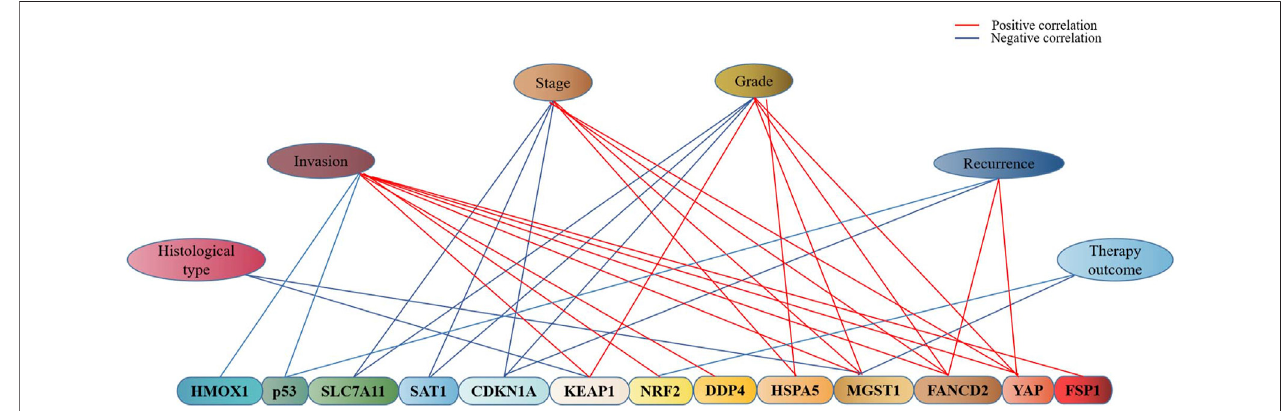
FIGURE3| Association offerroptosis-associated geneswith clinicalcharacteristics ofendometrialcancer.As indicated inthe graph, there exists anassociationof ferroptosis-associated genes with the stage, grade, invasion, recurrence, histopathological type, and therapy outcome of endometrial cancer, blue represents the negative and red represents the positive.